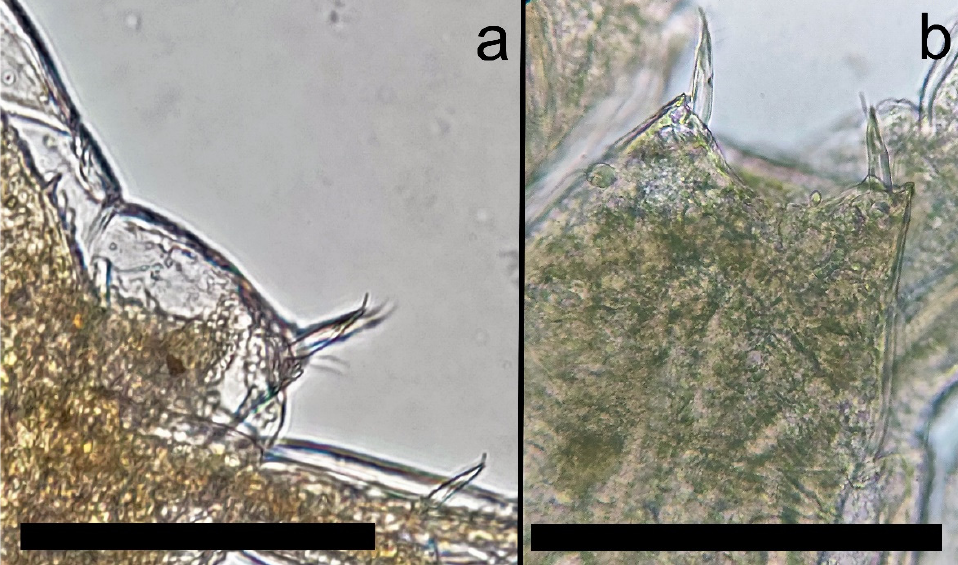
Figure 8. Megamphosus katagani : ( a ) lateral view of telson ( b ). dorsal view of telson. Scale bar for all the pictures: 0.5 mm. Photo credit: Emanuele Mancini.